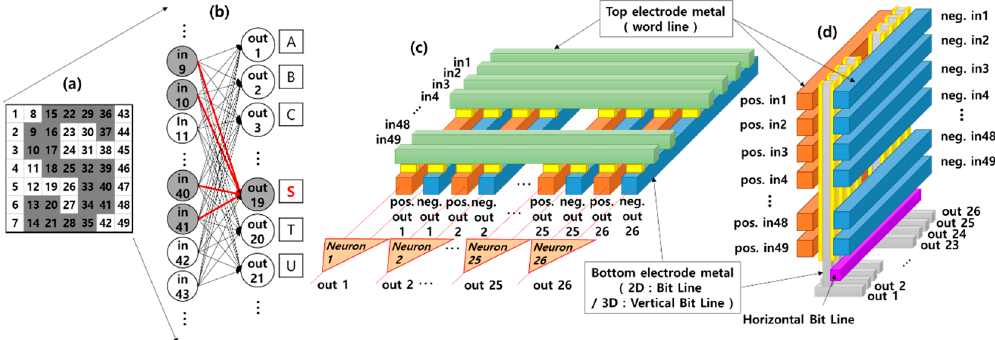
Figure 1. ( a ) The input pattern for letter ‘S’. ( b ) A neural network consisting of 49 input neurons and 26 output neurons (red lines = increased weights in the learning process) ( c ) Two-dimensional (2D) crossbar array synapses for implementing the neural network as shown in (b). ( d ) 3D vertical resistive random-access memory (VRRAM) synapses with the same performance as the synapses in (c).